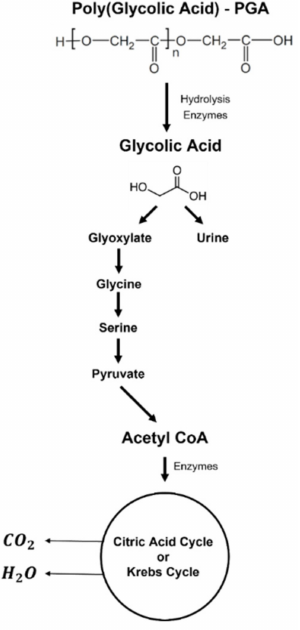
Figure 7. Biodegradation process of